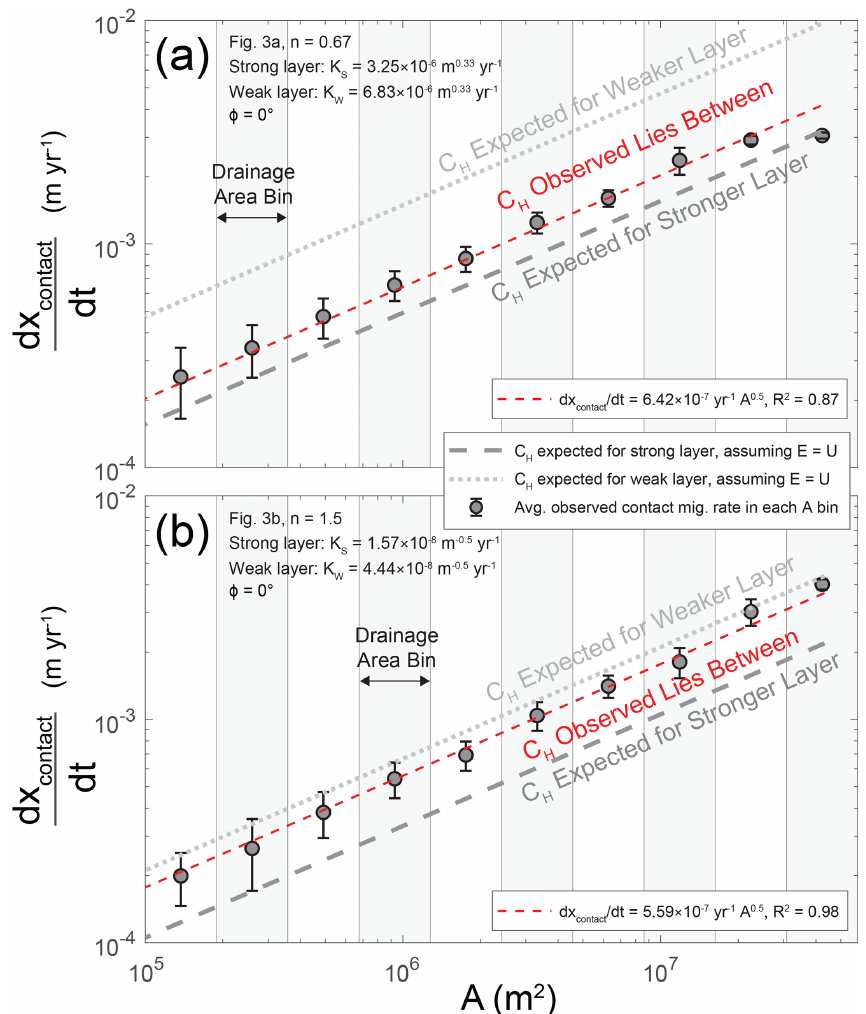
Figure 4. Contact migration rates (d x contact / d t ) vs. drainage area ( A ) for (a) the simulation shown in Fig. 3a and c and (b) the simulation shown in Fig. 3b and